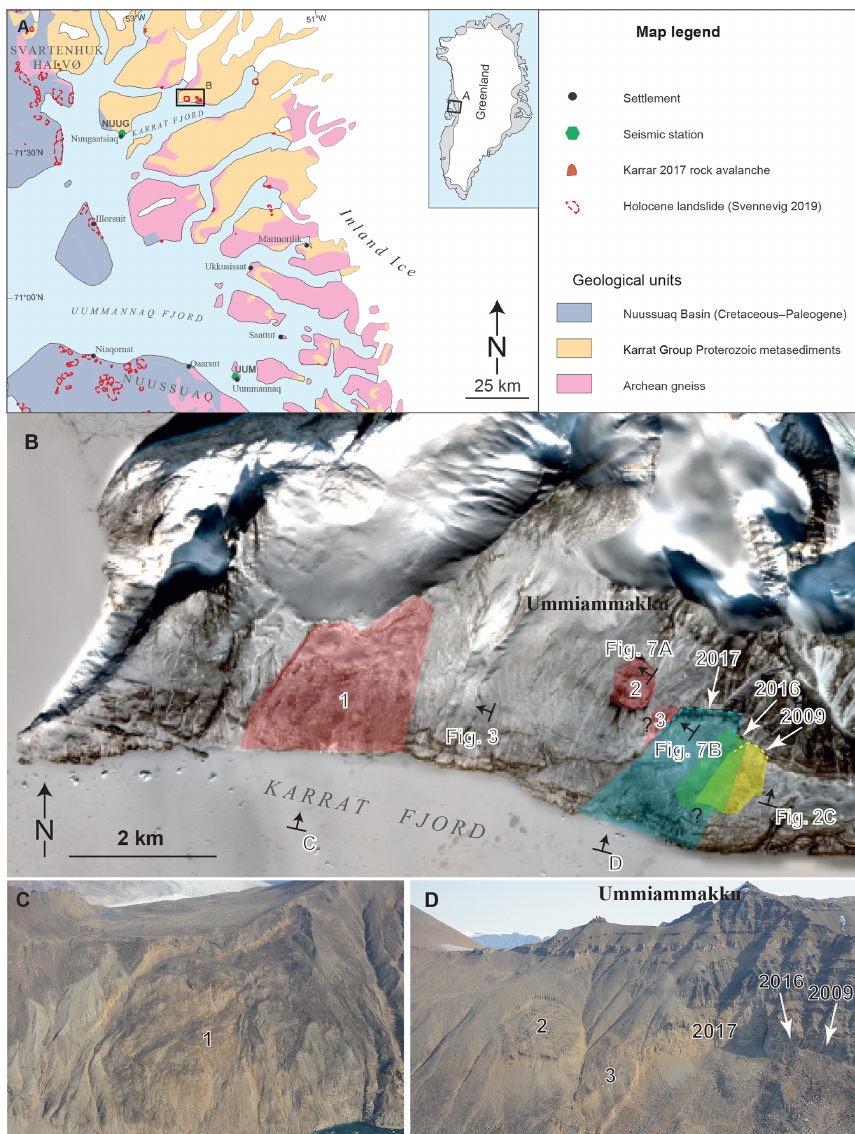
Figure 1. Setting of the Karrat Landslide Complex. (a) Simplified geological map of the region based on Henriksen et al. (2009) showing nearby seismic stations (NUUG and UMMG), prehistoric landslides (Svennevig, 2019), and the area of (b) . (b) The Karrat Landslide Complex shown on a Sentinel-2 RGB image from 20 April 2019 where the coastal slope has a light snow cover emphasizing the structures. Transparent polygons are the three rock avalanches (2009, 2016, and 2017) and the three unstable slopes (1, 2, and 3). The stippled lines at the rock avalanches are the extent of the individual scarps. Notice the recent rockfall from area 2 (dark stria south of the area). Positions, name (letter), and direction of field photos in this and subsequent figures are indicated with arrows. (c) Oblique helicopter photo of area 1. From the shore to the top of the back scarp is 1000m, and the back scarp is up top 120m high for scale. (d) Oblique helicopter photo of areas 2 and 3 and the three rock avalanches (2009, 2016, and 2017). Notice the hummocky morphology of areas 2 and 3 and the dust cloud east of area 3. Area 2 is 1200m across for